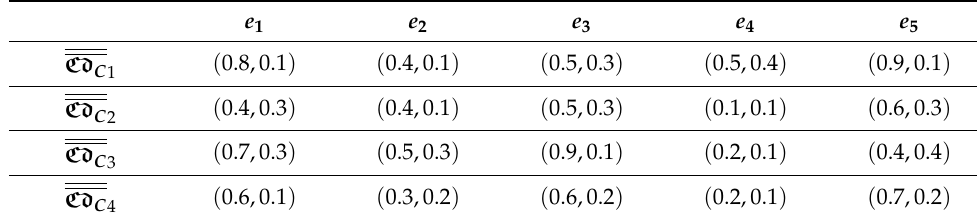
Table 4. Intuitionistic fuzzy soft matrix for Cd A 4 .